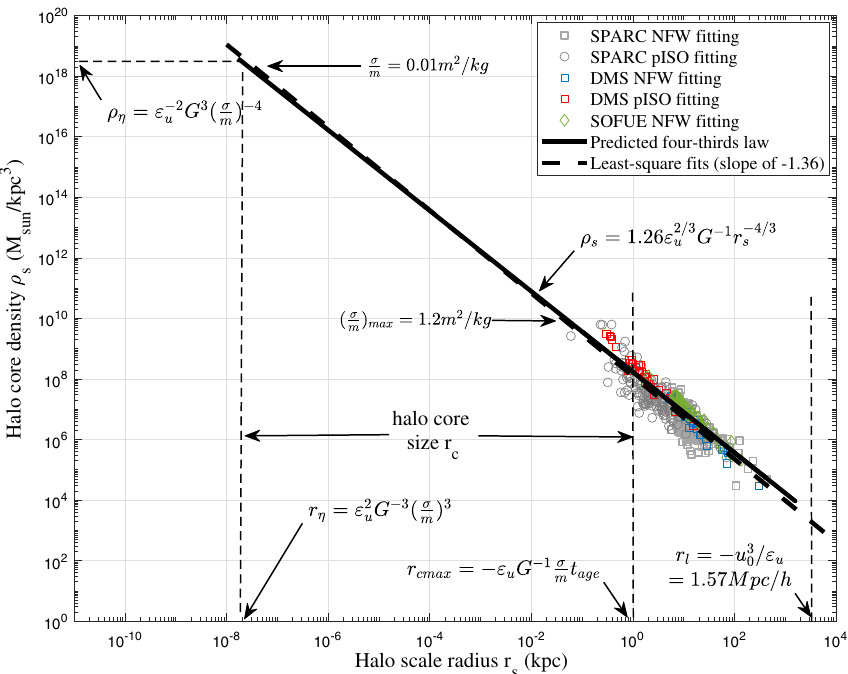
Figure 6. The predicted − 4/3 law tested against actual data from galaxy rotation curves. Good agreement confirms the existence of inverse energy cascade with a constant rate ε u . The self-interacting dark matter model should modify the lowest size r η and maximum density ρ η determined by the cross-section σ/ m , below which no coherent structure can exist. The largest possible core size r cmax due to self-interaction is determined by the age of haloes t age . The largest scale r l is determined by the velocity dispersion u 0 and ε u